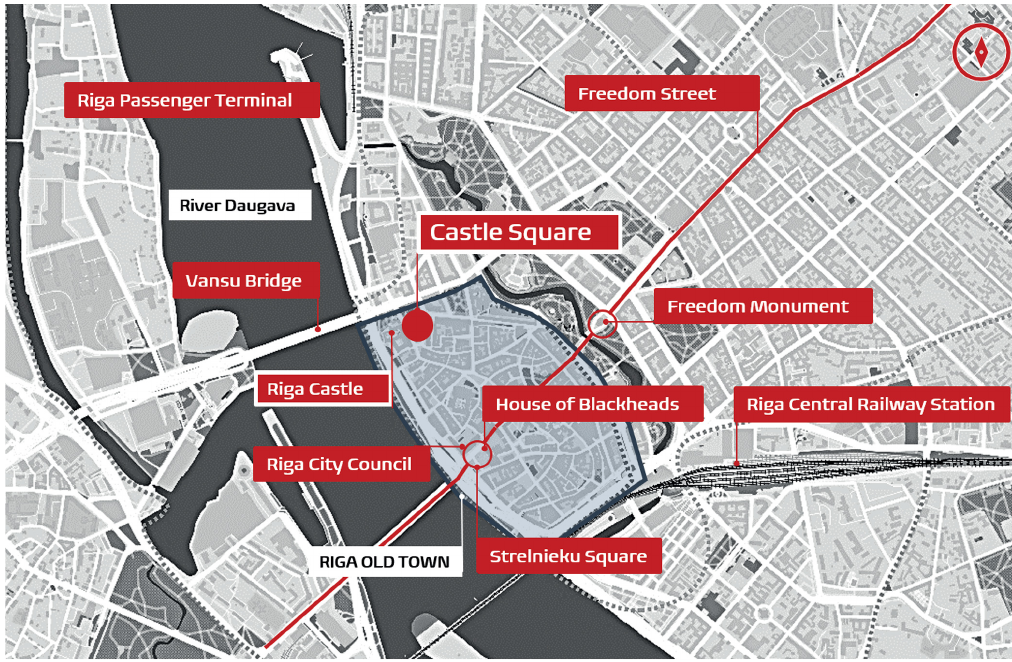
Figure 1. Situation of the Castle Square in Riga Old